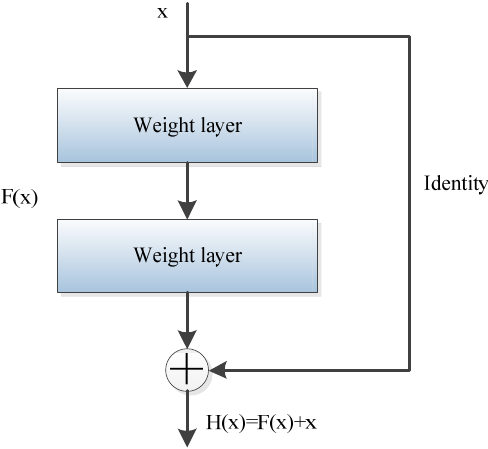
Figure 3. The architecture of residual network.